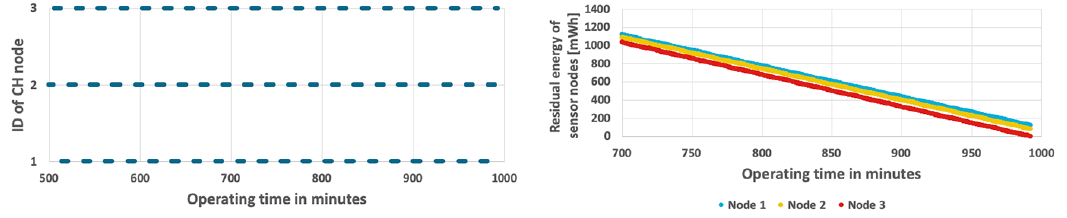
Figure 16. Energy consumption by sensor nodes for FDCR algorithm and fixed probability of event occurrence.